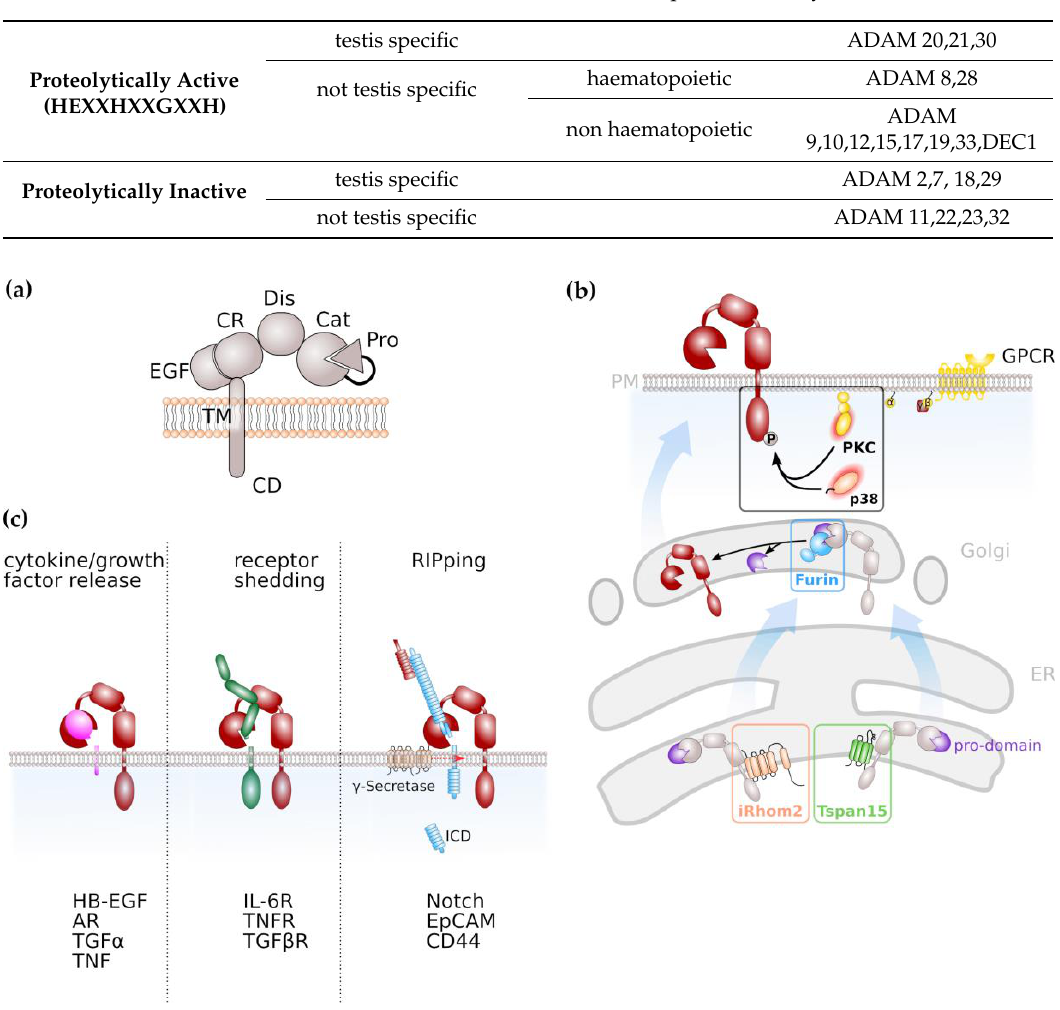
Figure 1. ADAMs and ADAM-mediated signalling pathways. ( a ) General domain structure of ADAM proteases. Pro, pro-domain; Cat;catalytic domain; Dis, disintegrin domain; CR, cysteine-rich domain; EGF, EGF-like domain; TM, transmembrane domain; CD, cytoplasmic domain ( b ) Maturation of ADAM protease, notably ADAM10 and ADAM17 is facilitated by tetraspanins (Tspans) and inactive rhomboid proteases (iRhom), respectively. Activation of ADAM proteases, notably ADAM17, via C-terminal phosphorylation is mediated by protein kinase C (PKC) or the mitogen-activated kinase p38. ( c ) ADAM proteases have diverse substrates and are involved in cytokine/growth factor release, shedding of receptor molecules and the induction of intracellular signal transduction via limited proteolysis, followed by regulated intramembrane proteolysis (RIP).